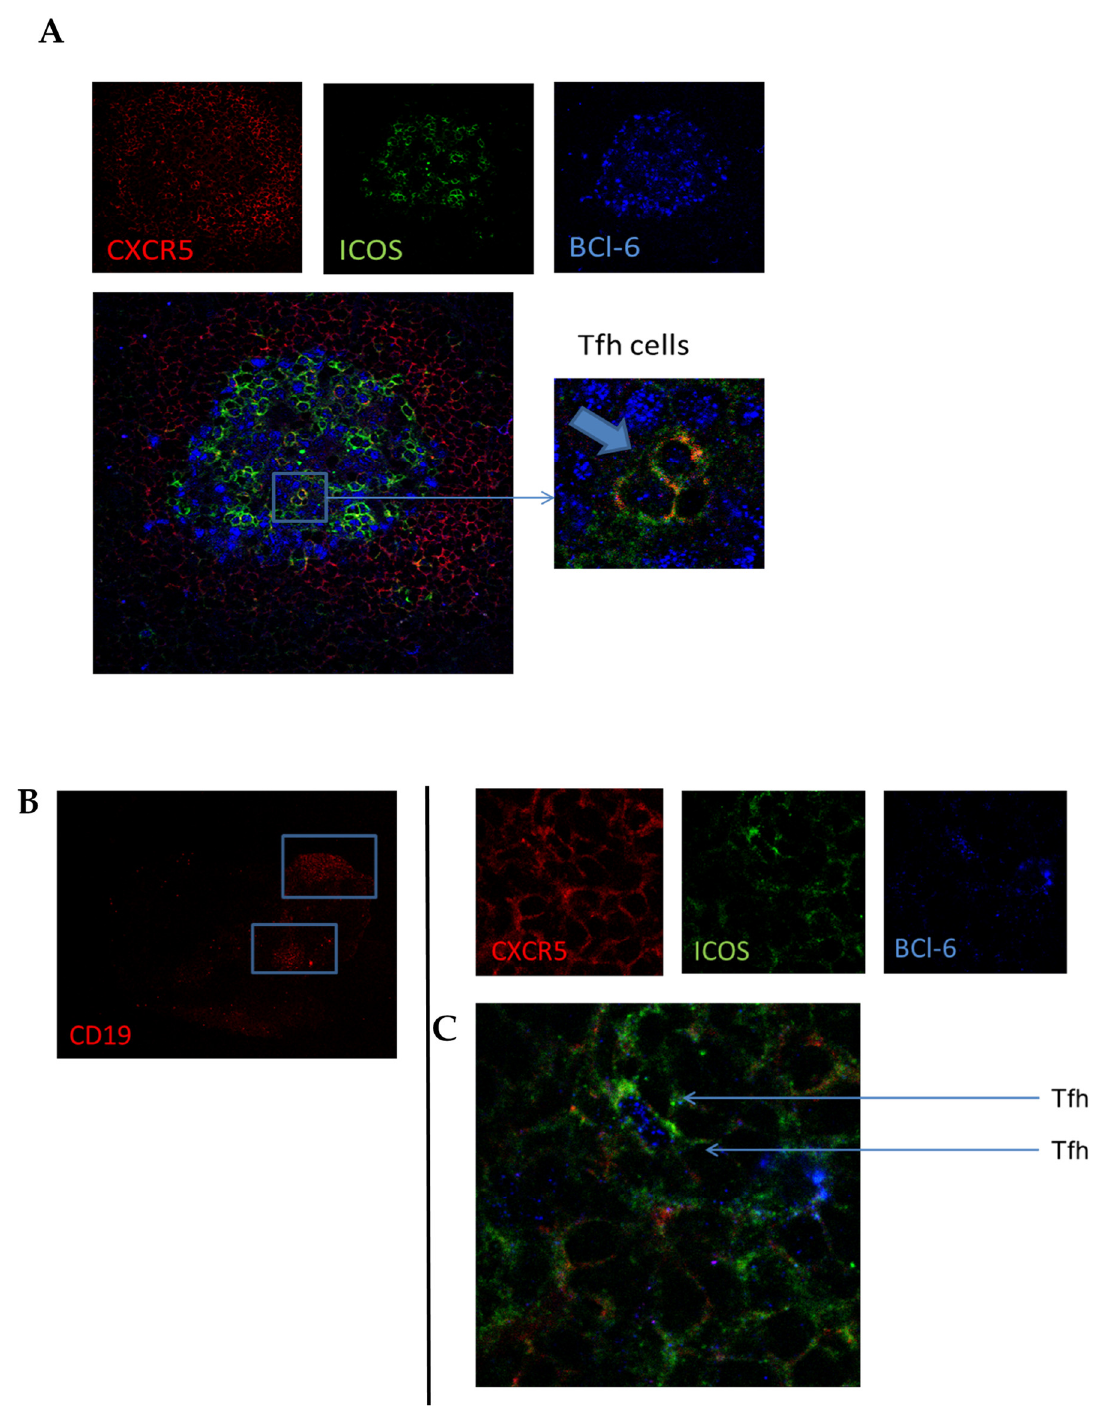
Figure 4. Confirmation of follicular T cells in ( A ) human lymph node tissue. ( B , C ) Identification of B cells ( B ) and follicular T cells ( C ) in B-cell-rich areas of consecutive synovial tissue sections. Lymph node tissue sections and synovial tissue sections from RA patients were stained for CXCR5, ICOS, and Bcl6. Pictures are representative of n = 5 experiments. In 63 × zoom, image arrows indicate triple-positive Tfh cells.